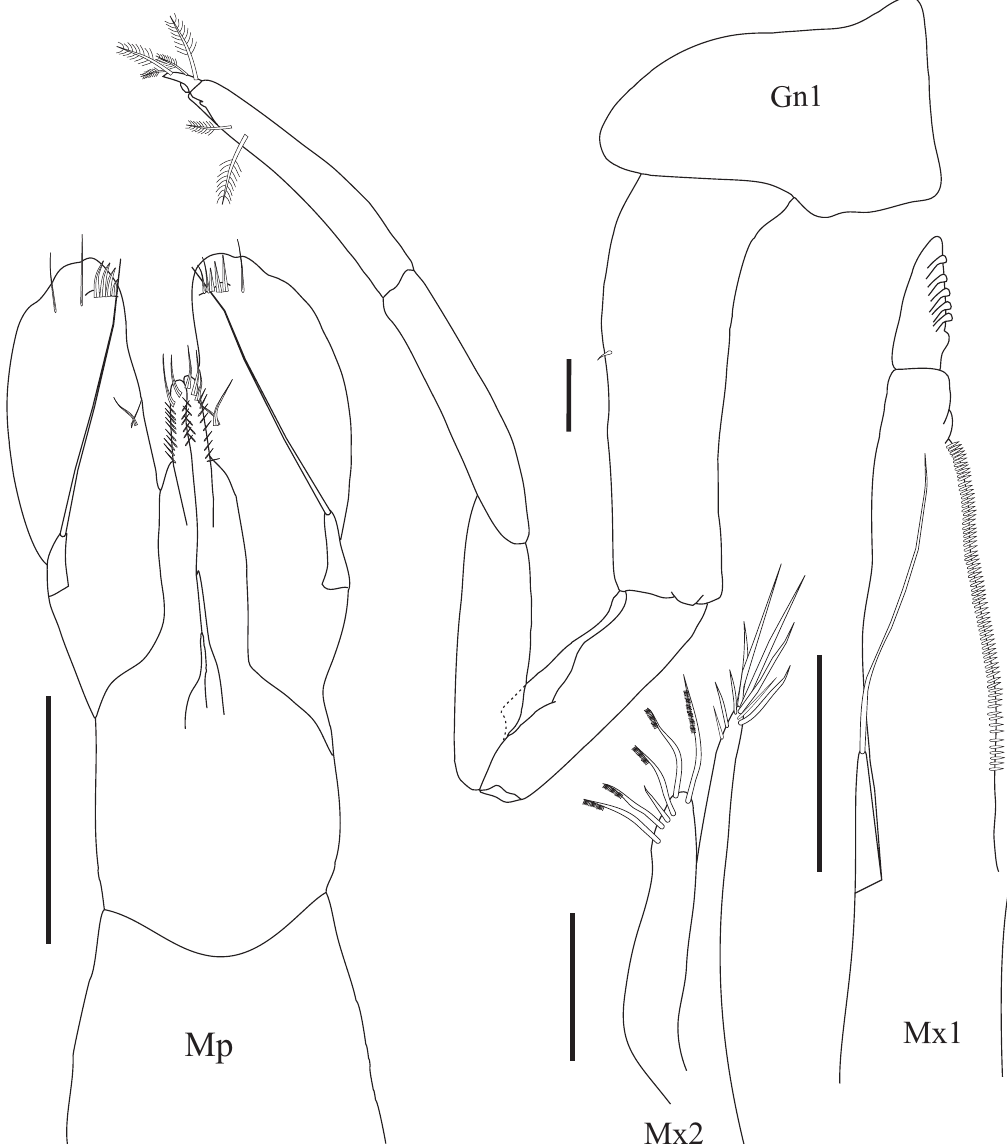
Fig . 3. – Curidia wakabarae n. sp., reVizee Benthos sCore/northeast, holotype female, 2.42 mm, Fernando de noronha Chain: Pequeno island, station #88a (3.83°s; 34.71ºW), MnrJ 20868. scale bar = 0.1 mm. Gn1: gnathopod 1; Mp: maxilliped; Mx: